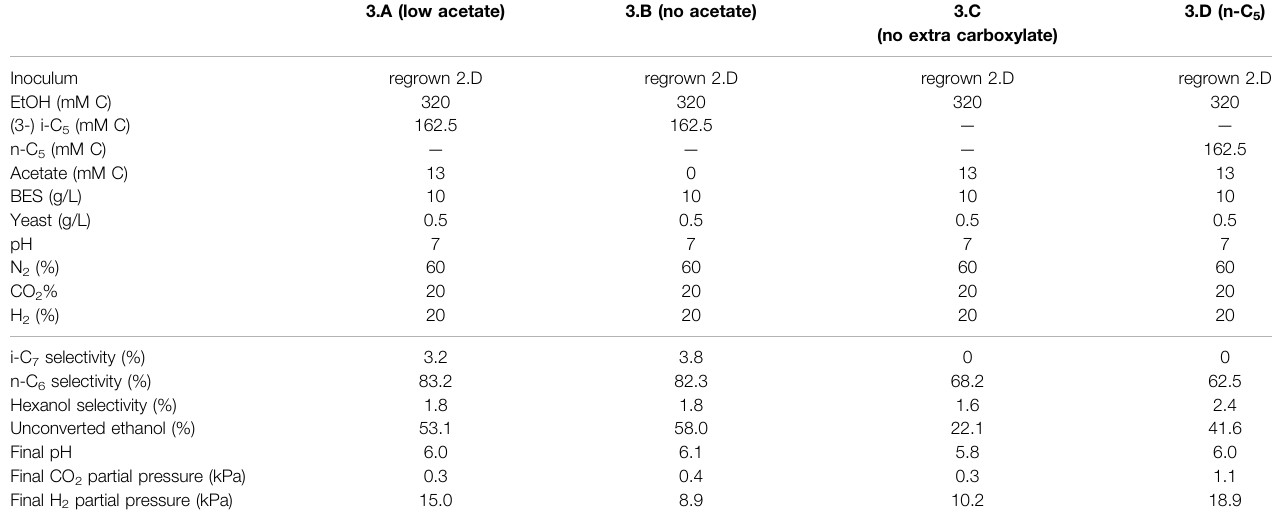
TABLE 4 | Overview of the different starting parameters (t (cid:2) 0) for the third batch series, as well as fi nal values (t (cid:2) end) for product selectivites (% of total formed compounds based on carbon atoms) of i-C 7 , n-C 6 and hexanol, the percentages of unconverted ethanol at the end of the batch, pH and partial pressures of CO 2 and H 2